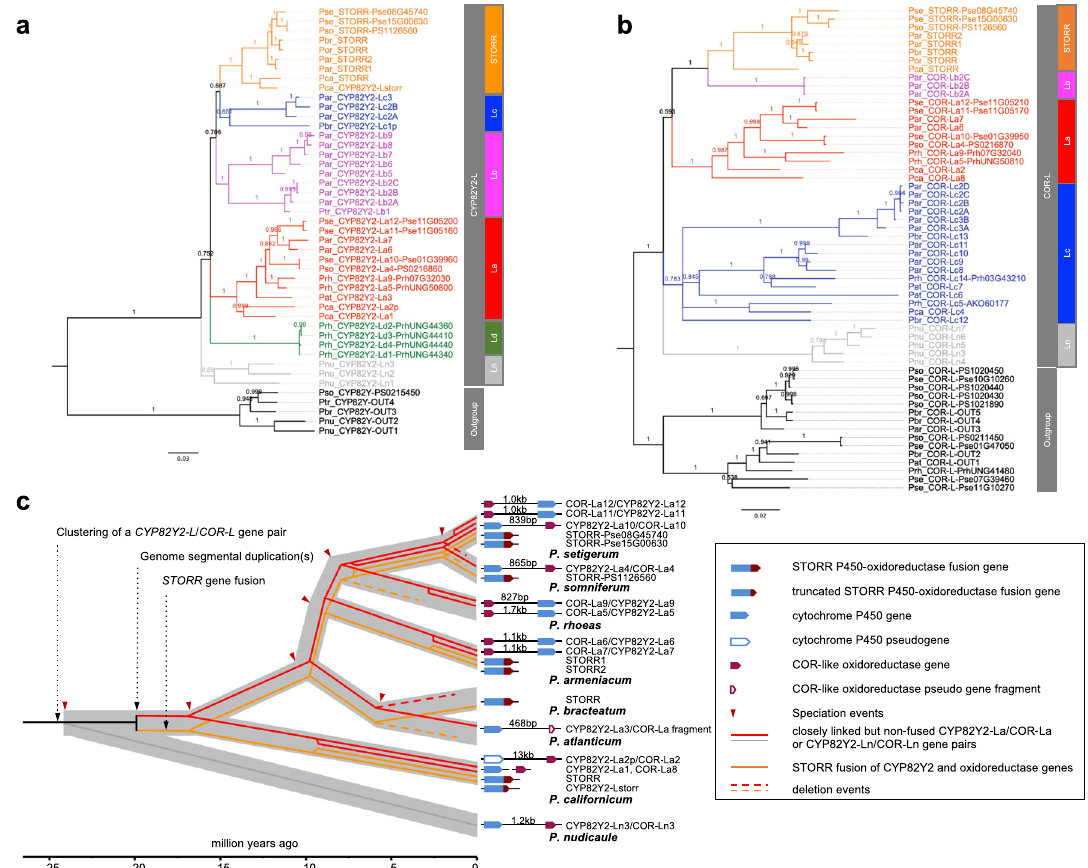
Fig. 3 Evolutionary history of the formation of STORR fusion gene inferred from gene tree analyses of its P450 CYP82Y2 and oxidoreductase modules. a Phylogenetic gene tree of CYP82Y2-L P450 subfamily constructed using Bayesian Inference. b Phylogenetic gene tree of COR-L oxidoreductase subfamily constructed using Bayesian Inference. The posterior probabilities are shown on the branches and scale bar represents substitutions per nucleotide site. Both trees were rooted based on branch position of orthologous outgroup containing P. somniferum sequences CYP82Y-PS0215450 for CYP82Y2-L tree and COR_L-PS0211450/PS1020430/PS1020440/PS1020450/PS1021890 for the COR-L tree as described in Li et al. 6 . STORR , La, Lb, Lc, Ld and Ln are de fi ned as orthologous subgroups and their members are highlighted by coloured branches. A three letter pre fi x followed by an underscore is used as a species identi fi er for each gene; including Par P. armeniacum , Pat P. atlanticum , Pbr P. bracteatum , Pca P. californicum , Pnu P. nudicaule , Por